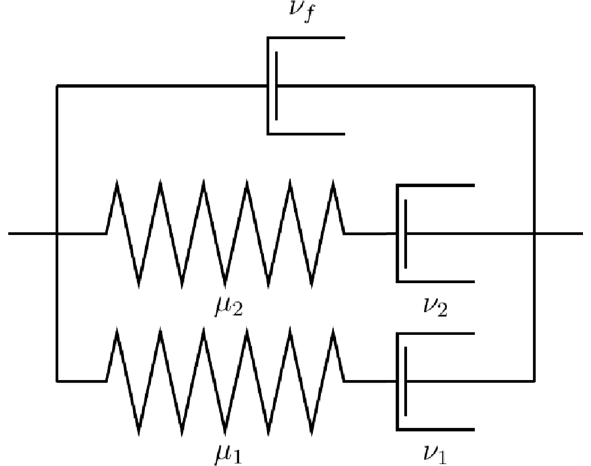
Fig. 1 The Burgers-type